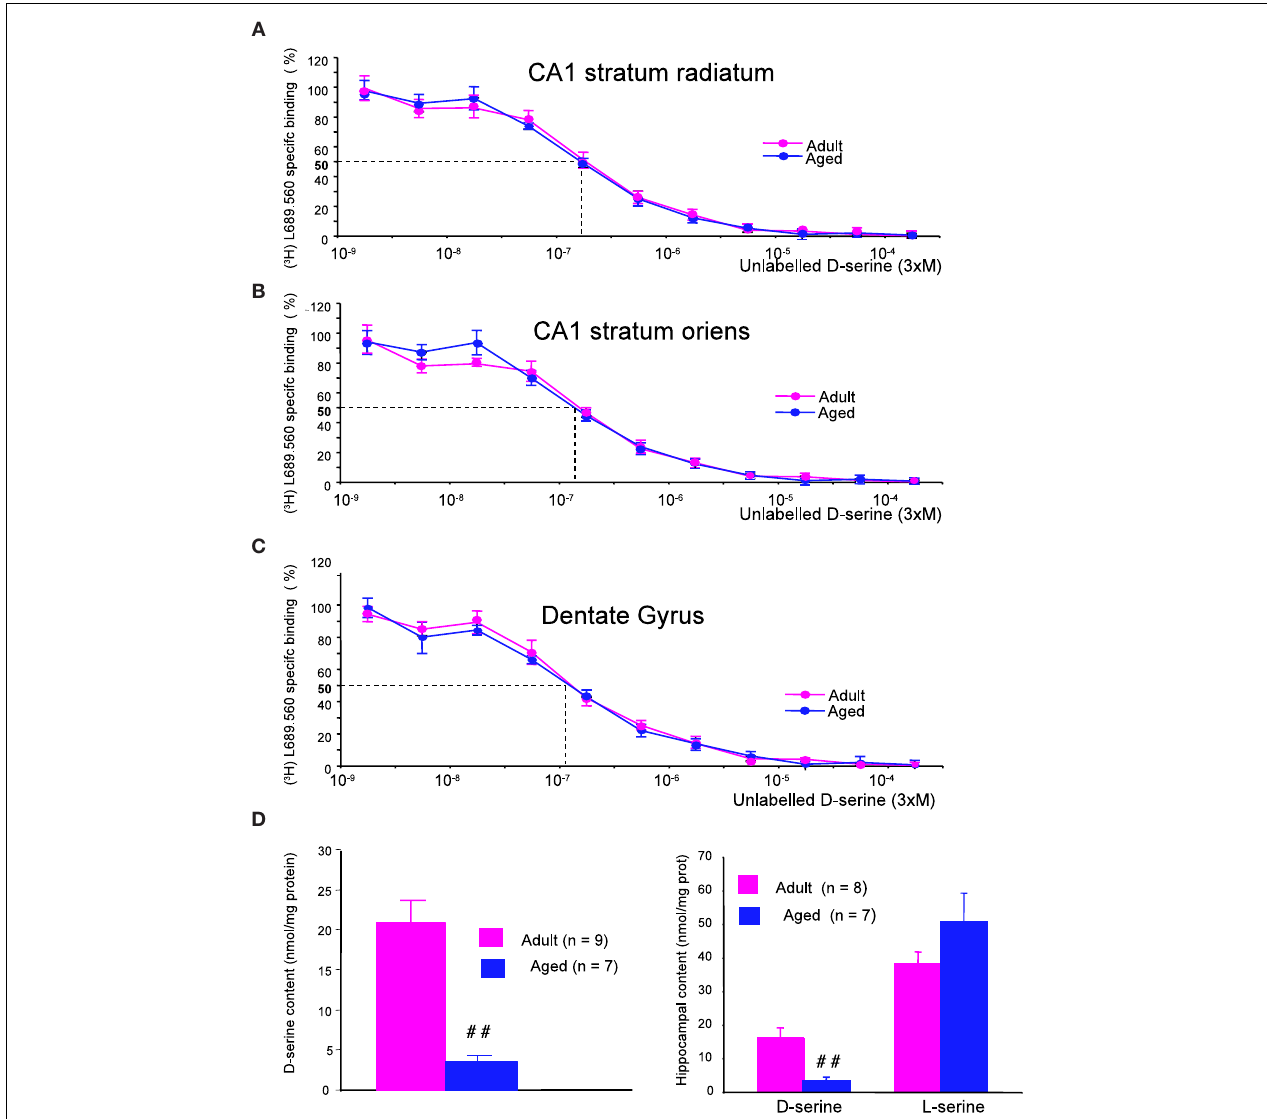
FIGURE 4 | Aging does not alter the affi nity of D -serine binding sites but decreases D -serine availability. Representative mean displacement curves of specifi c [ 3 H] L689.560 binding by D -serine in the stratum radiatum of the CA1 (A) , the stratum oriens of the CA1 (B) and the dentate gyrus (C) respectively of